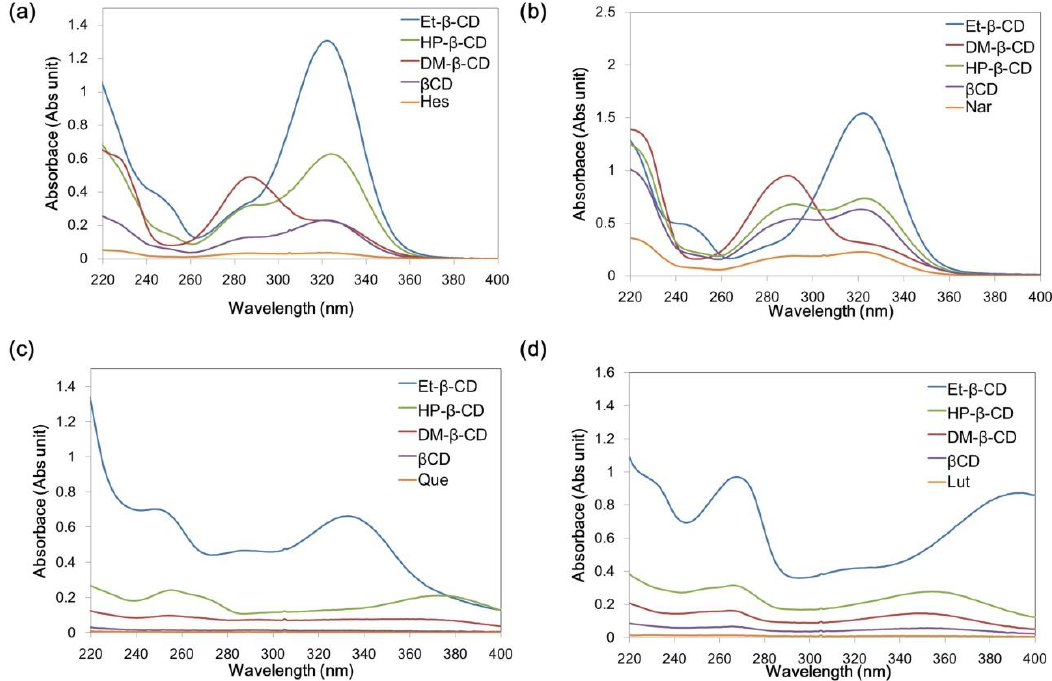
Figure 2. Ultraviolet-visible (UV-Vis) absorption spectra of the flavonoids and their complexes: ( a ) Hesperetin (Hes); ( b ) Naringenin (Nar); ( c ) Quercetin (Que); and ( d ) Luteolin (Lut) in the absence (orange) and presence of β-cyclodextrin (β-CD, purple), dimethyl-β-CD (DM-β-CD, red), 2- hydroxypropyl-β-CD (HP-β-CD, green), and ethylenediamine-modified β-CD (Et-β-CD, blue).